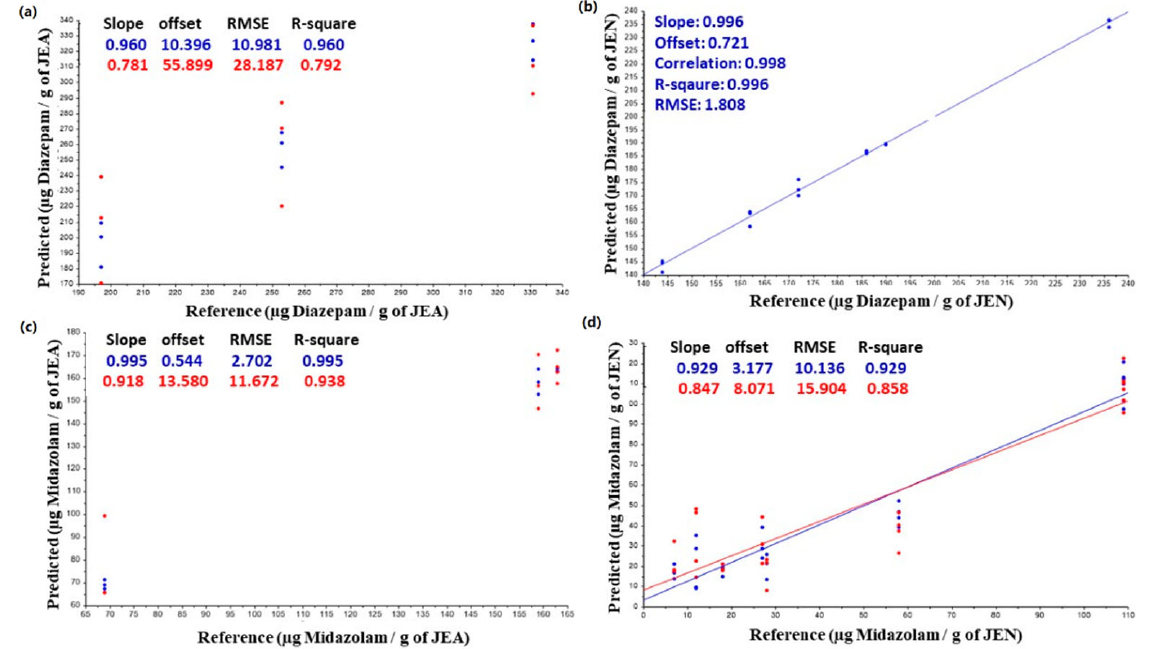
Figure 9. PLSR model to correlate NIR spectroscopic signal from the elastomer surface and drug retained in the gasket. Key: ( a ) DJEA; ( b ) DJEN; ( c ) MJEA; and ( d ) MJEN.